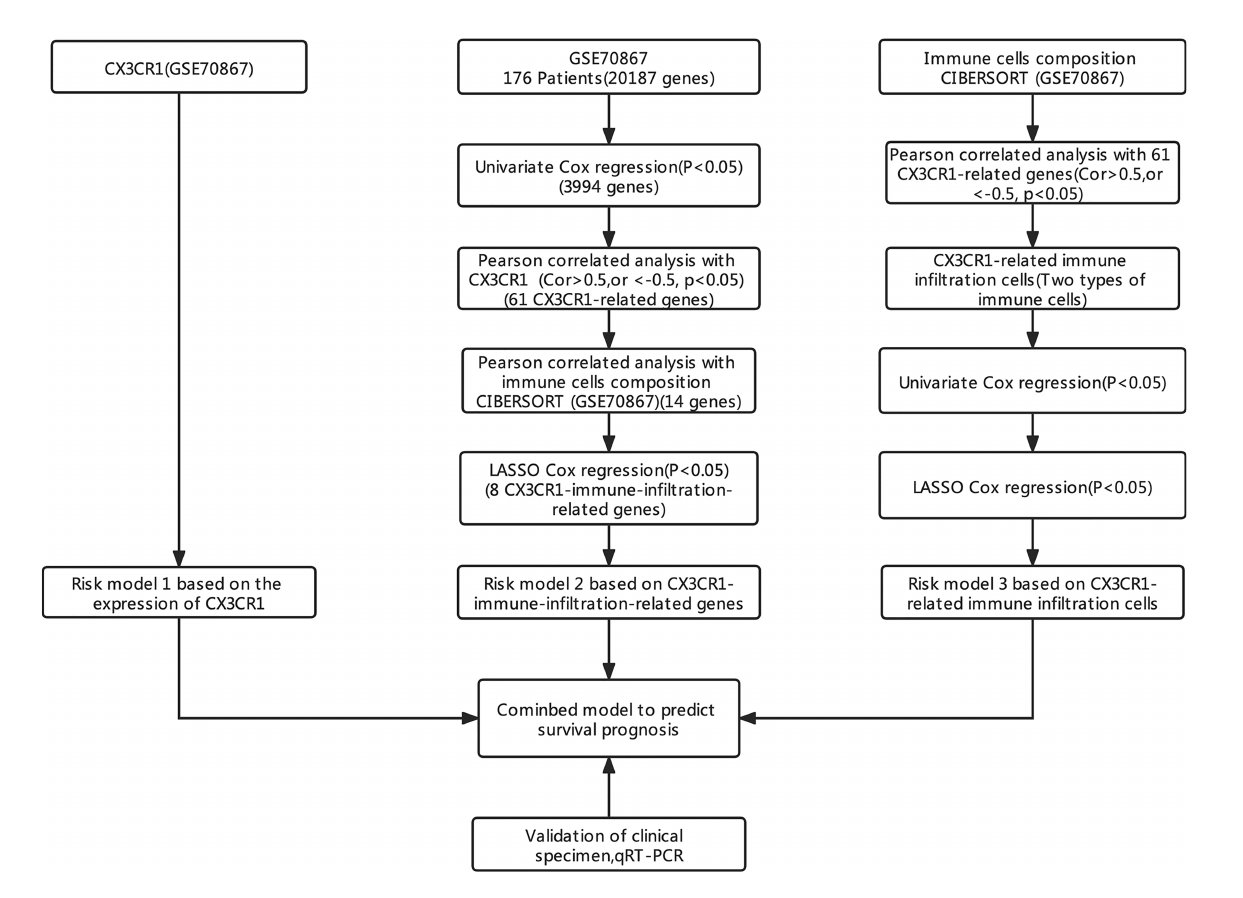
FIGURE 1 | The research ideas and analysis